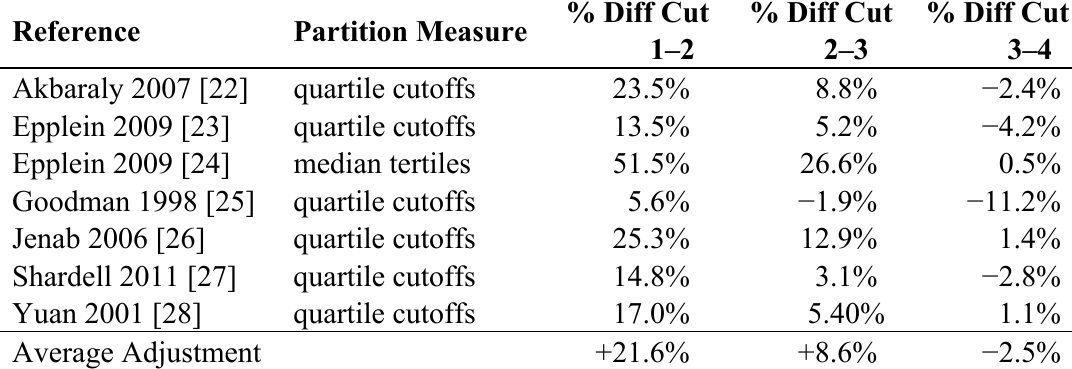
Table 1. Adjustment Calculation for Reporting Total Carotenoids from Individual Carotenoids. Percent difference between the sum of the individual carotenoids and reported total carotenoid values are given here for studies that gave three partition values.